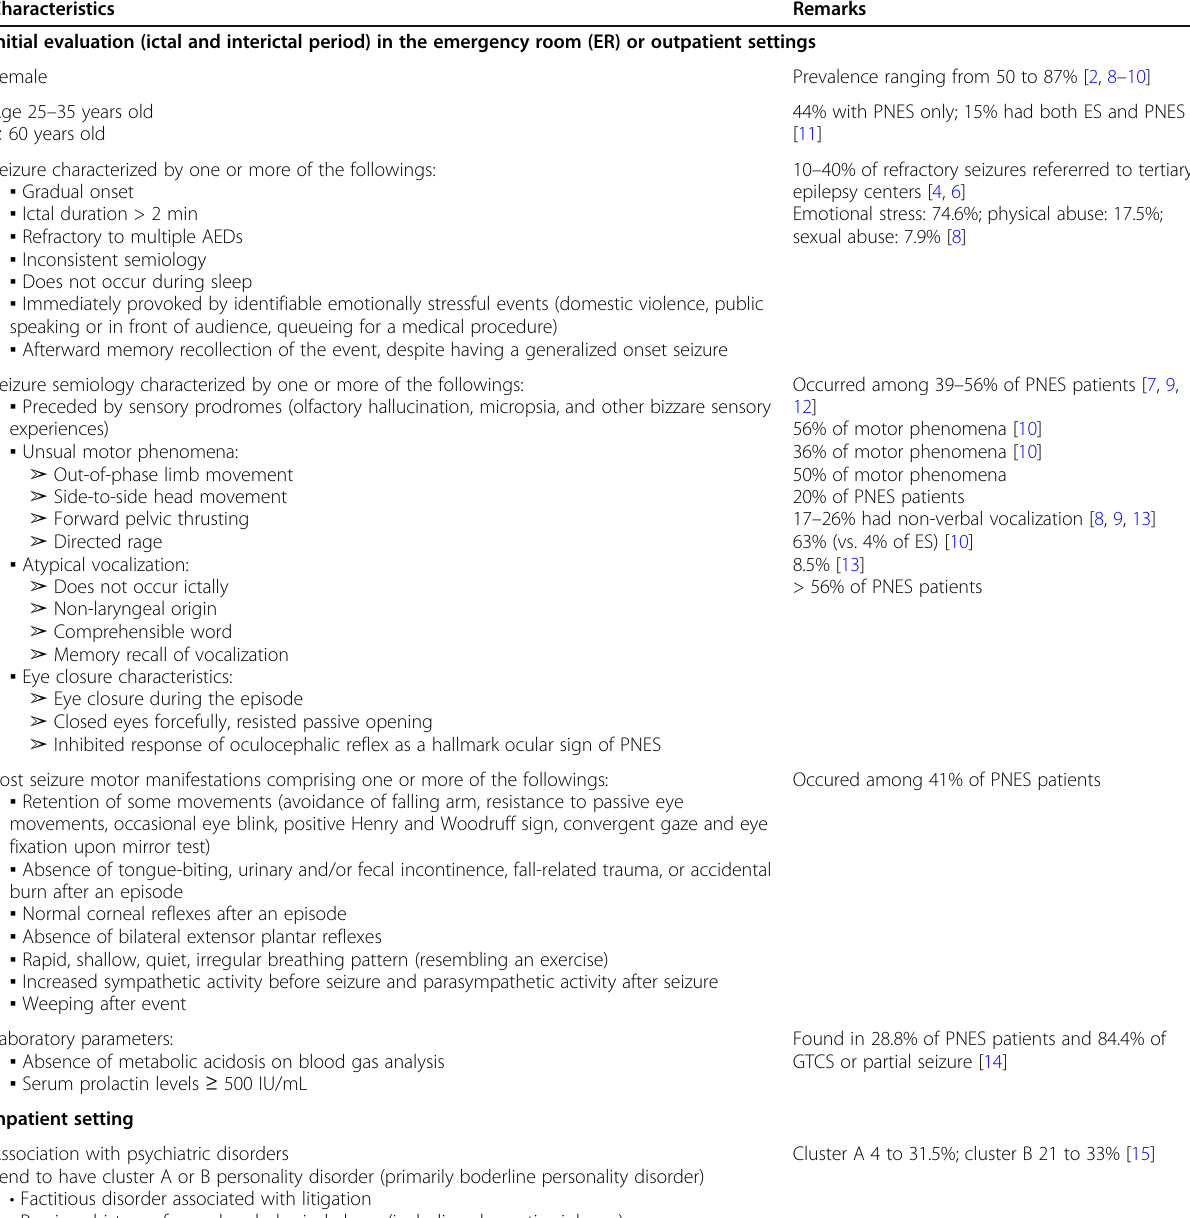
Table 1 Summary of “ yellow ” clinical characteristics (yellow flag checklist) of PNES patients